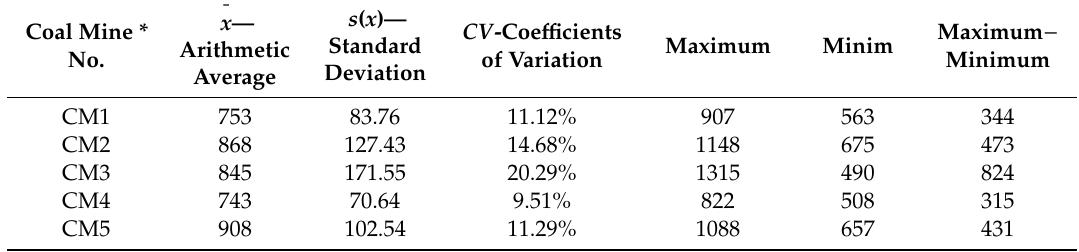
Table 1. Descriptive statistics for labor productivity in examined coal mines (in Mg per employee).